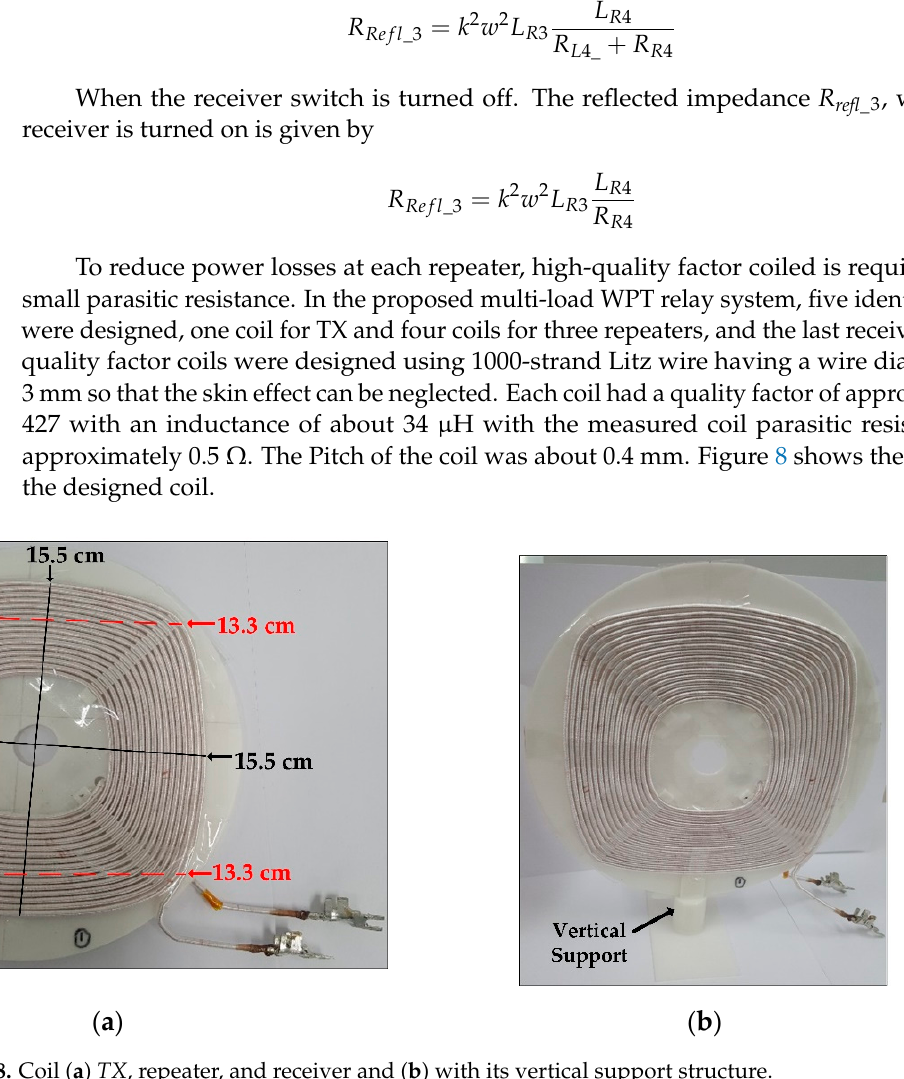
Figure 8. Coil ( a ) TX , repeater, and receiver and ( b ) with its vertical support